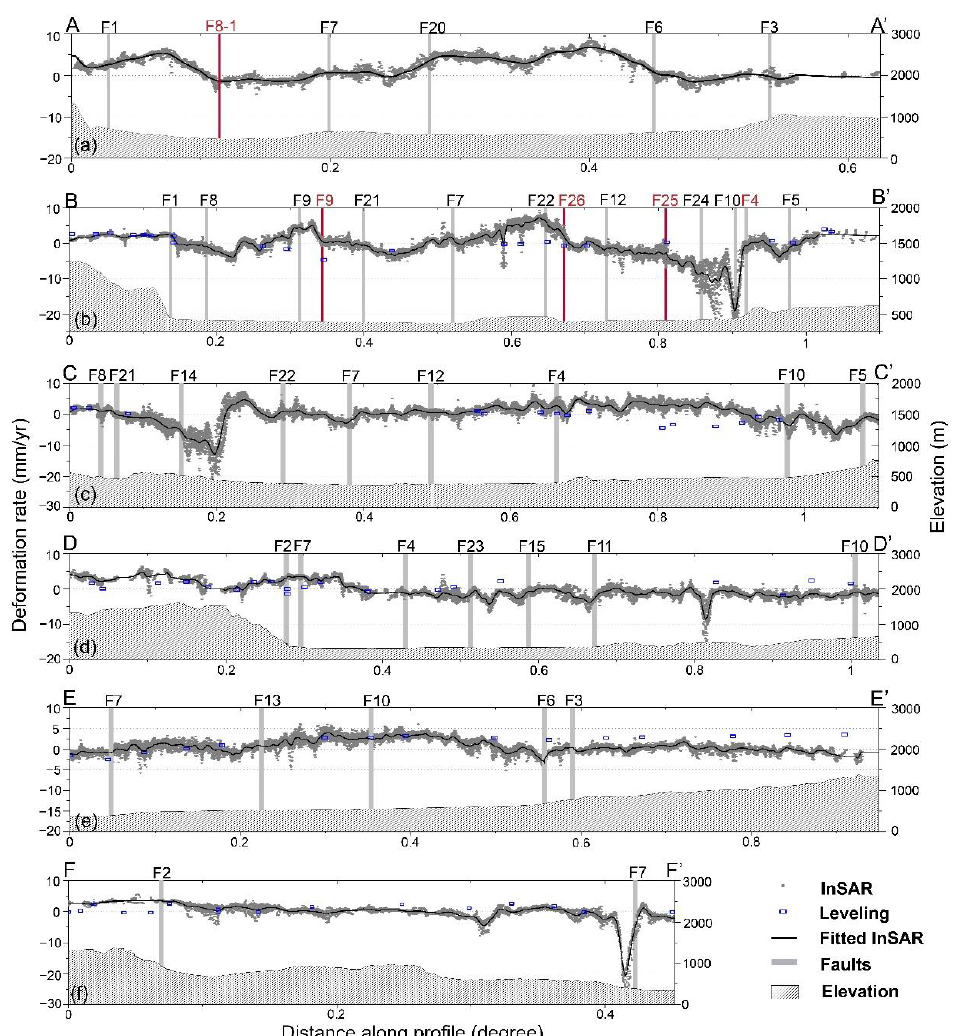
Figure 5. Average vertical deformations along six profiles, as shown in Figure 5. The gray dots show the InSAR vertical observations, and the squares display the leveling measurements. The vertical gray and red lines represent fault locations. The gray shadows show the corresponding surface heights.